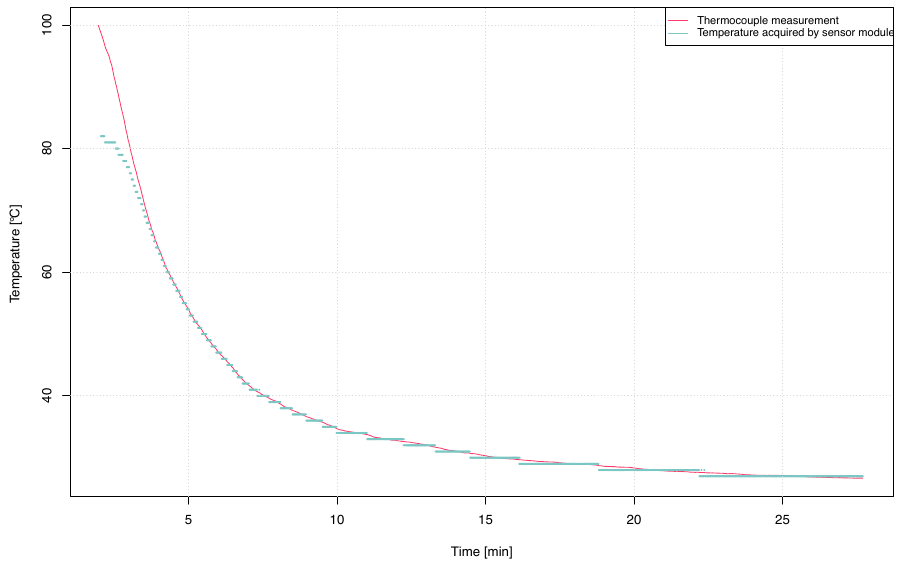
Figure 10. Thermal step response measurements comparison between thermistor with a custom measurement algorithm, and thermocouple results.